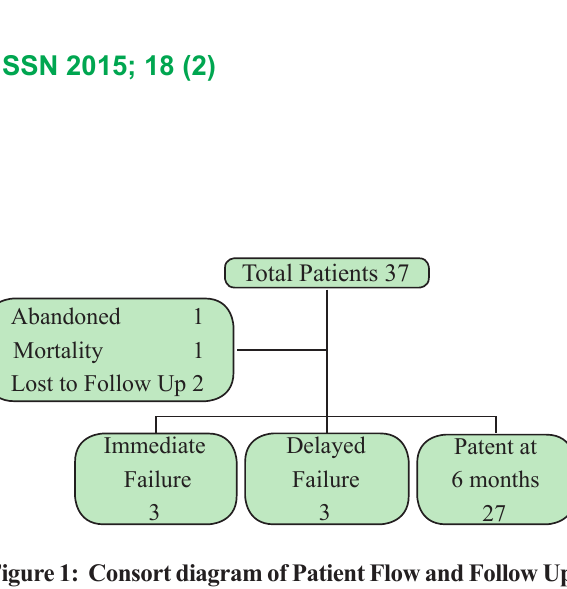
Figure 1: Consort diagram of Patient Flow and Follow Up The maturation time varied between 3-7 weeks (mean +/- SD of 4.83 +/- 1.053). Four patients (10.81%)